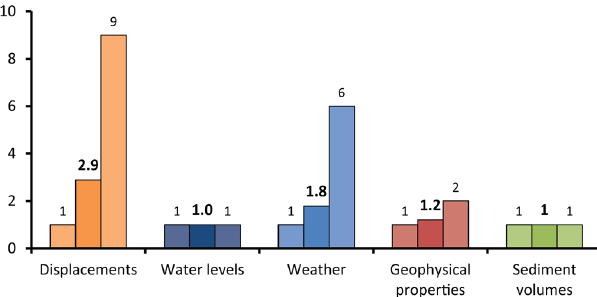
Fig. 8. Minimum, mean and maximum instrument types used to monitor each parameter (when it is done) per